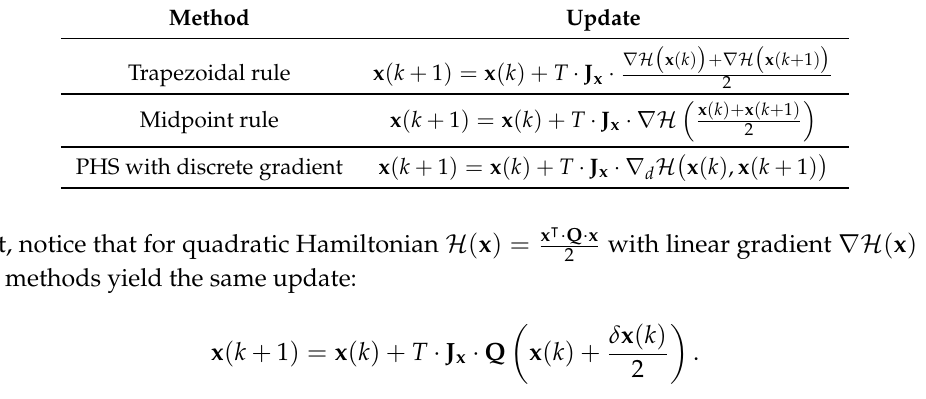
Table 3. Updates for the three methods considered in §4.3. PHS stands for port-Hamiltonian system. Method